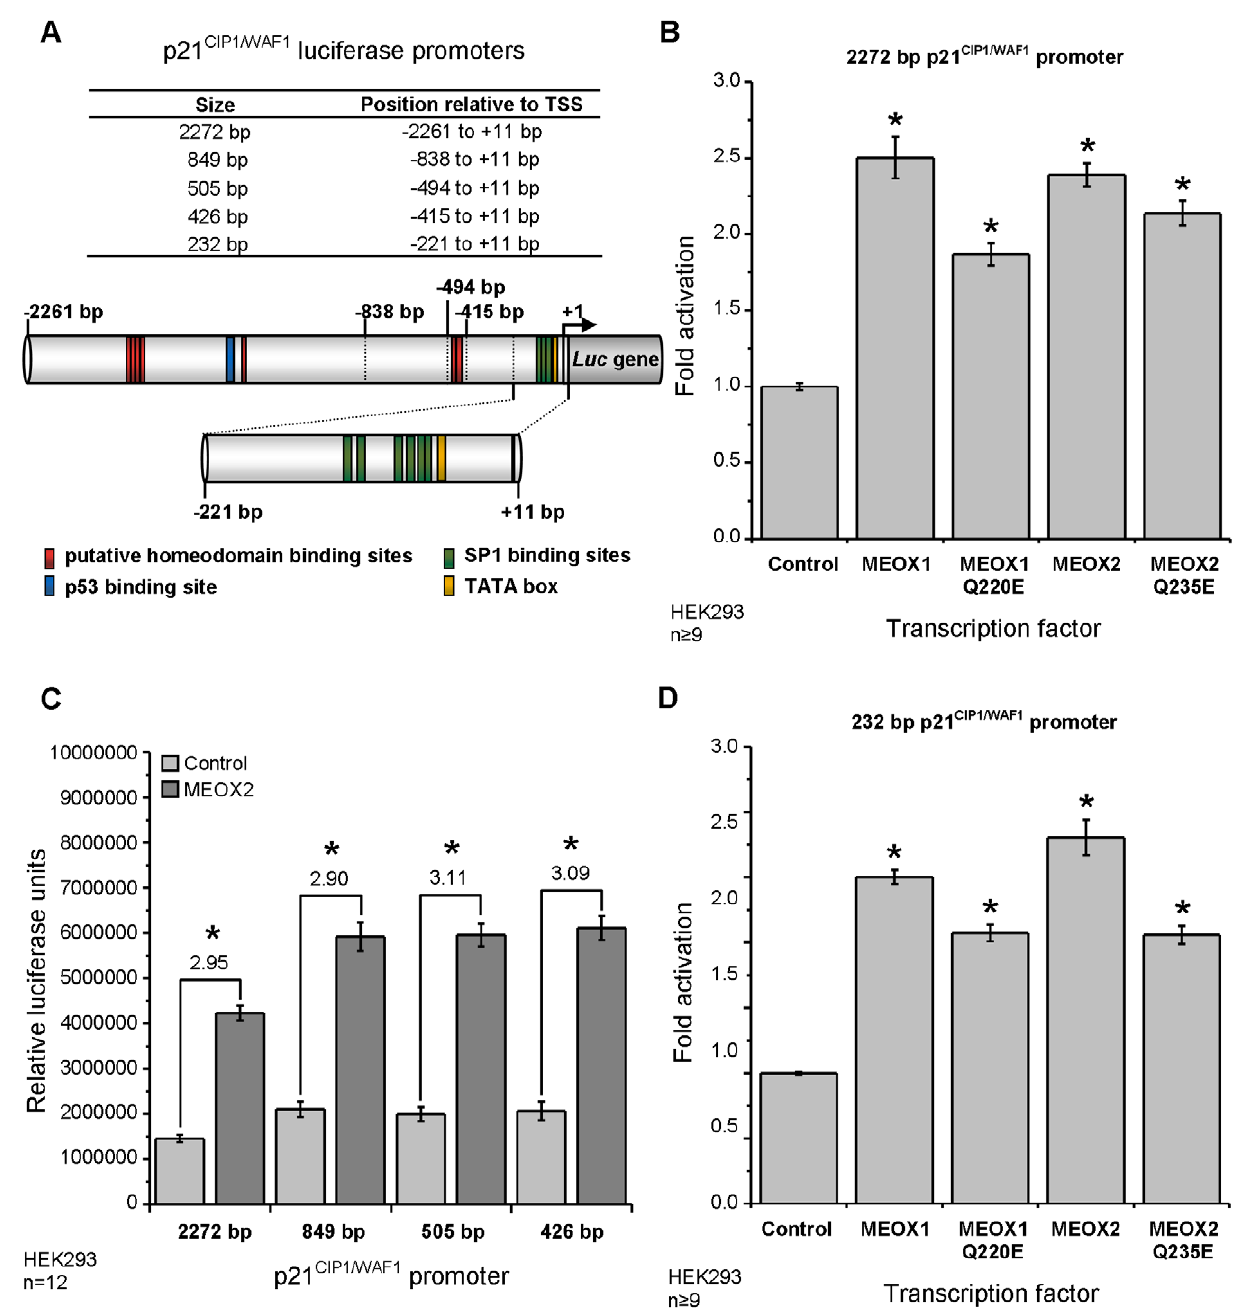
Figure 6. MEOX2 activates transcription from a minimal p21 CIP1/WAF1 promoter independent of its ability to bind DNA. A) Schematic diagram of the human p21 CIP1/WAF1 promoter luciferase constructs used in this paper. The 5 9 termini are indicated relative to the transcriptional start site (arrow). Relevant transcription factor binding sites (p53, homeodomain, SP1 and TATA) are also shown. B) Activation of the luciferase reporter gene from the 2272 bp p21 CIP1/WAF1 promoter by wild type MEOX1, MEOX2 and their respective DNA binding mutant versions MEOX1 Q220E and MEOX2 Q235E . C) Comparison of MEOX2 activation from the 2272 bp, 849 bp, 505 bp and 426 bp p21 CIP1/WAF1 promoters. The fold activation by MEOX2 compared to the empty vector control is indicated for each promoter. D) Activation of the luciferase reporter gene from the minimal 232 bp p21 CIP1/WAF1 promoter by wild type MEOX1, MEOX2 and their respective DNA binding mutant versions MEOX1 Q220E and MEOX2 Q235E . B-D). All luciferase assays were performed in HEK293 cells. * Indicates a statistically significant change (p , 0.05), when compared to the empty vector